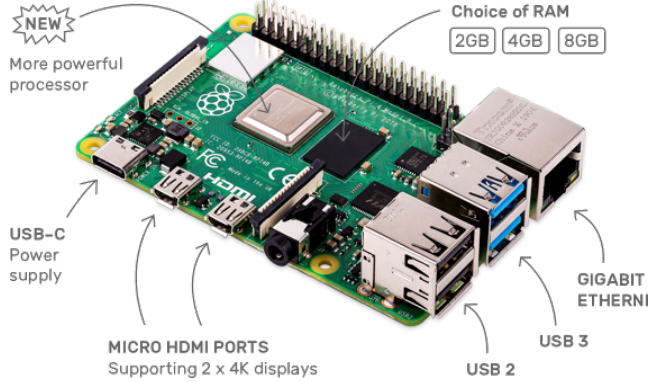
Figure 2. Raspberry Pi (4b) diagram.